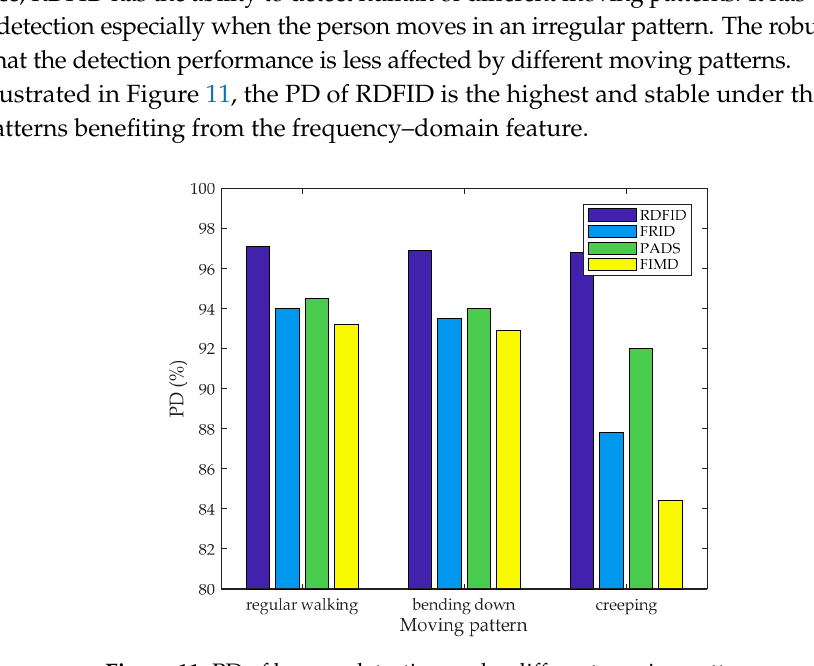
Figure 11. PD of human detection under different moving patterns.